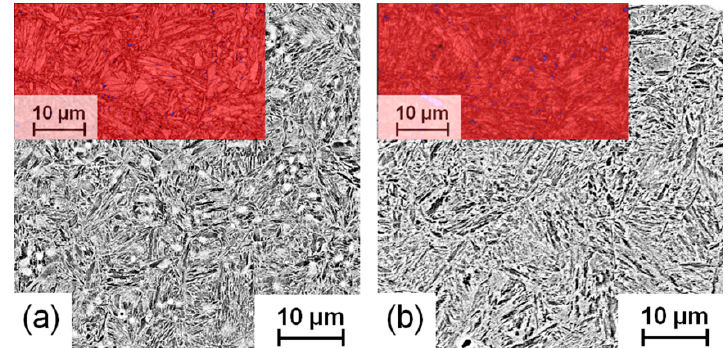
Figure 12. SEM micrographs of Q&P-B samples base material ( a ) and weld junction ( b ).